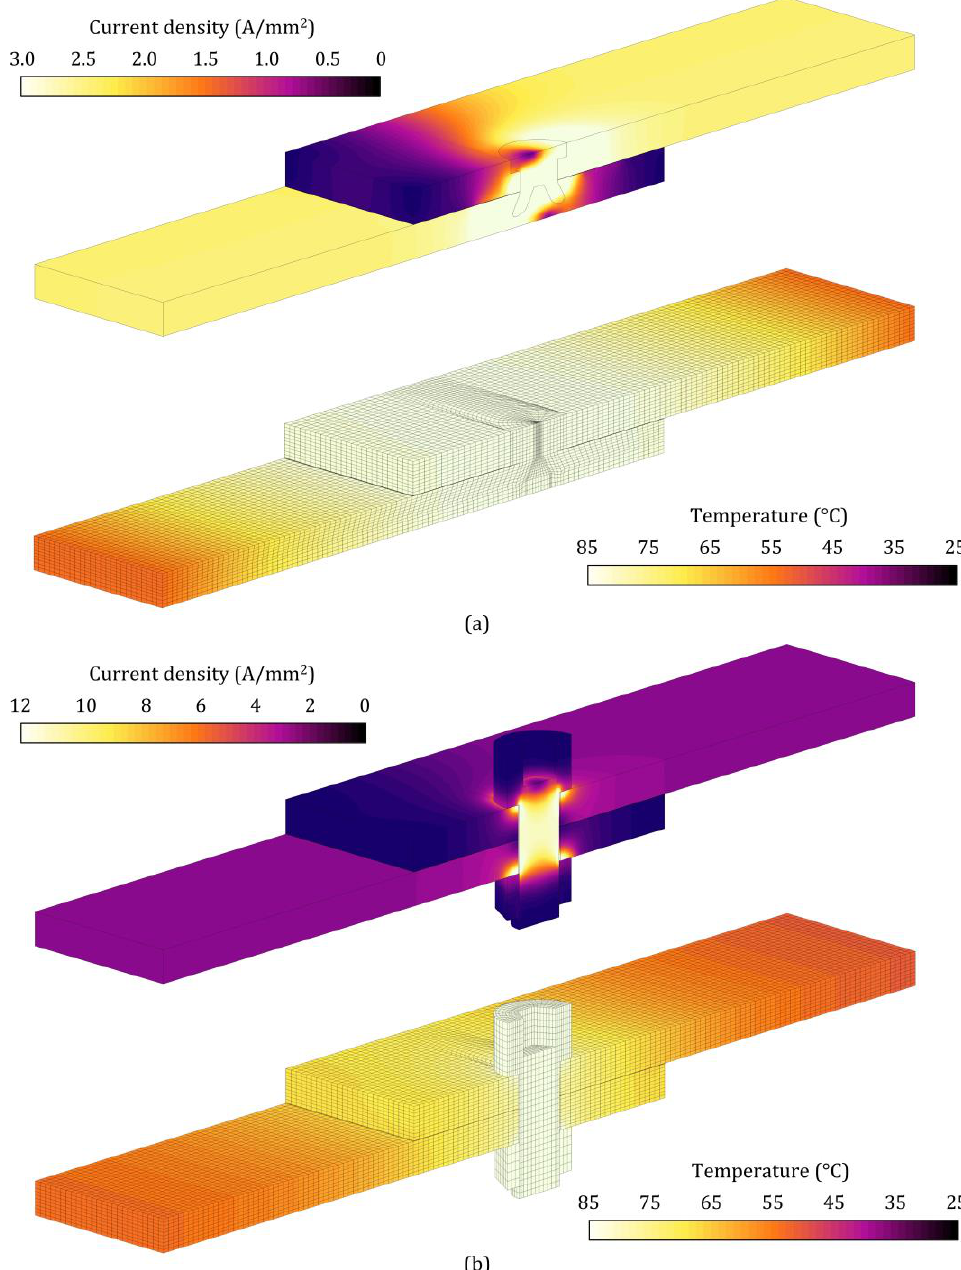
Figure 12. Finite element predicted distributions of electric current density (A/mm 2 ) and tempera- ture (°C) for the ( a ) injection lap riveted (counterbored) and ( b ) bolted unit cells when the temperature at the center is equal to 85 °C (during the cooling stage).